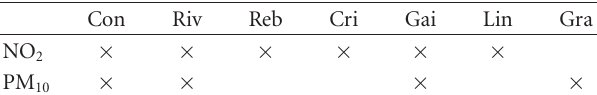
Table 1: Available chemical sensors at the sites: Consolata (Con.), Rivoli (Riv.), Rebaudengo (Reb.), Cristina (Cri.), Gaidano (Gai.), Lingotto (Ling.), and Grassi